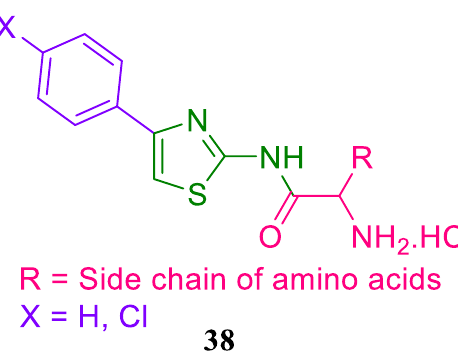
Figure 39. Amino acids-conjugated